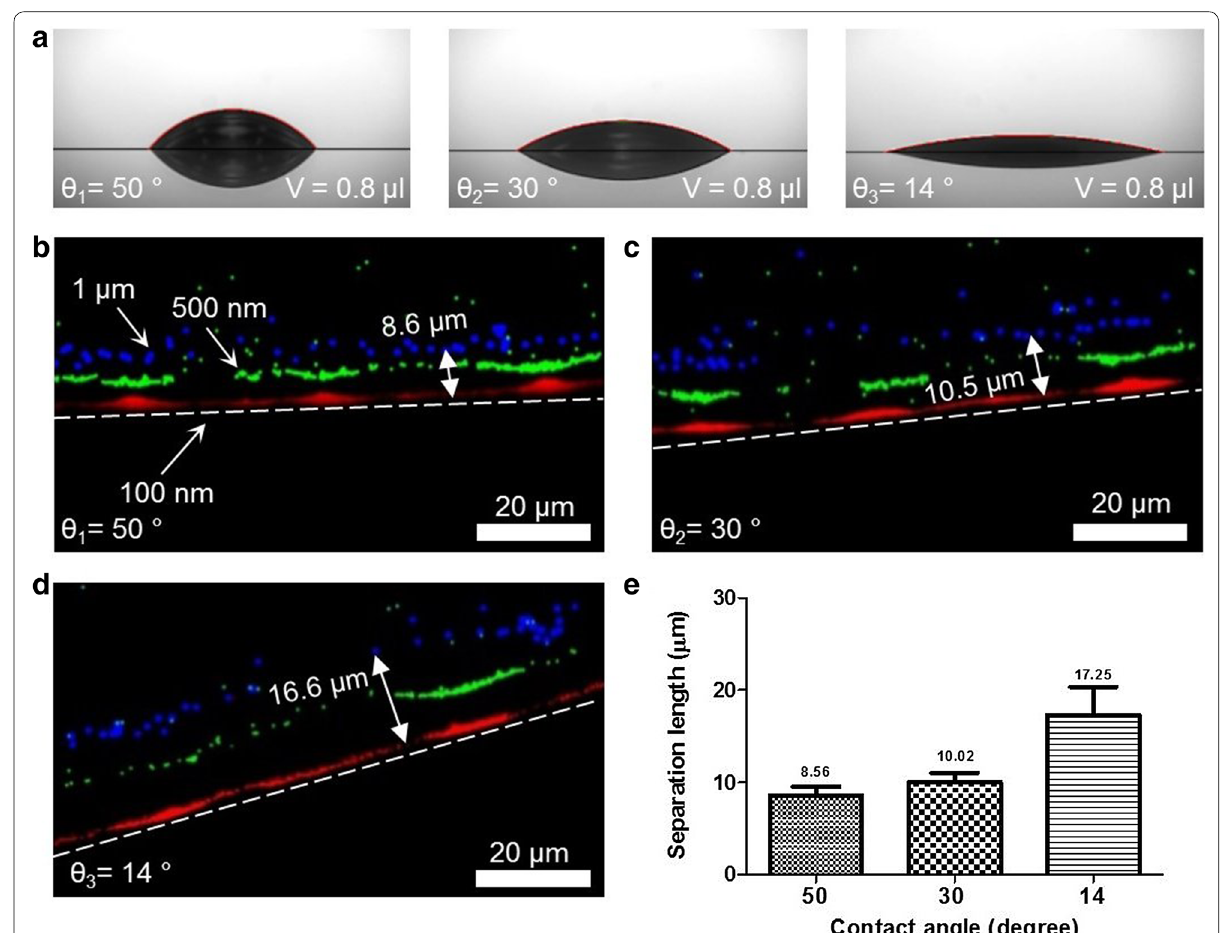
Fig. 5 Contact angle of droplet having same volume (0.8 µl) a θ 1 the evaporated droplet at b